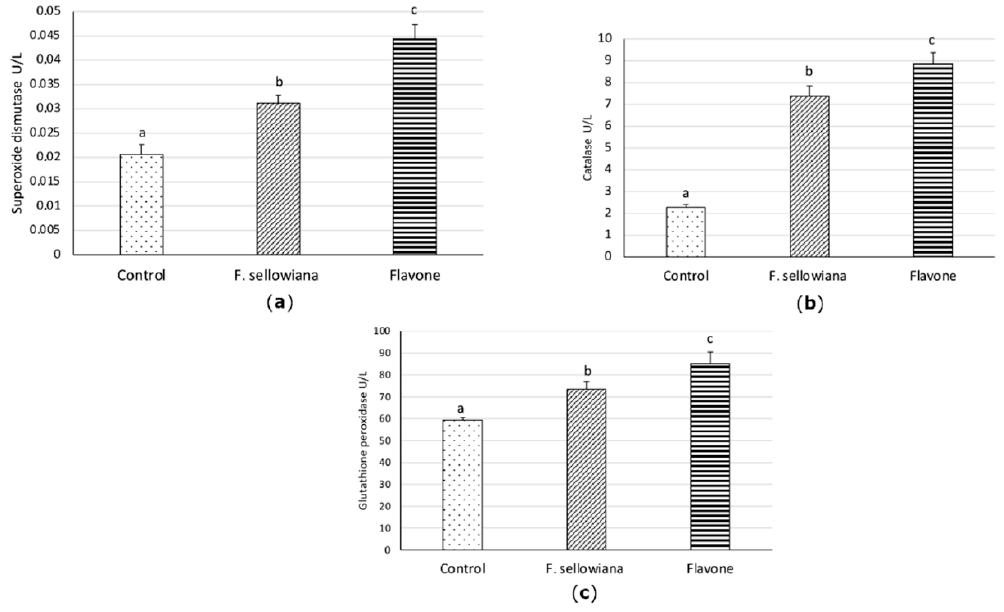
Figure 1. Effect of Feijoa sellowiana acetonic extract and flavone on the activity of antioxidant enzymes in polymorphonuclear cells. ( a ) Superoxide dismutase, ( b ) catalase and ( c ) glutathione peroxidase. Data were presented as mean and standard error and were analyzed with a paired t -test. Bars not accompanied by the same letter were significantly different at p < 0.05.